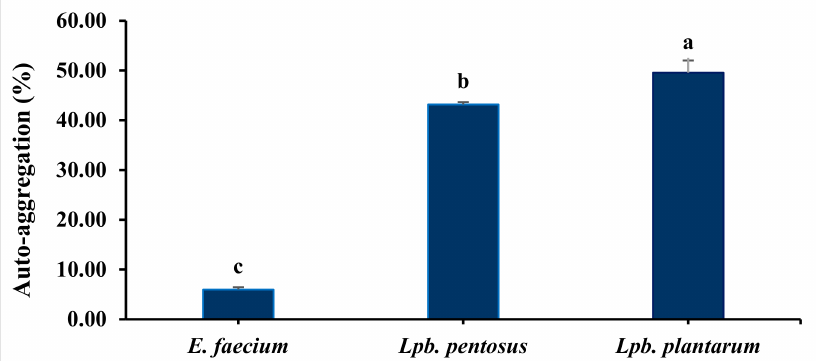
Figure 3. Auto-aggregation of E. faecium , Lpb. plantarum , and Lpb. pentosus . Different letters indicate significant differences between samples at p ≤